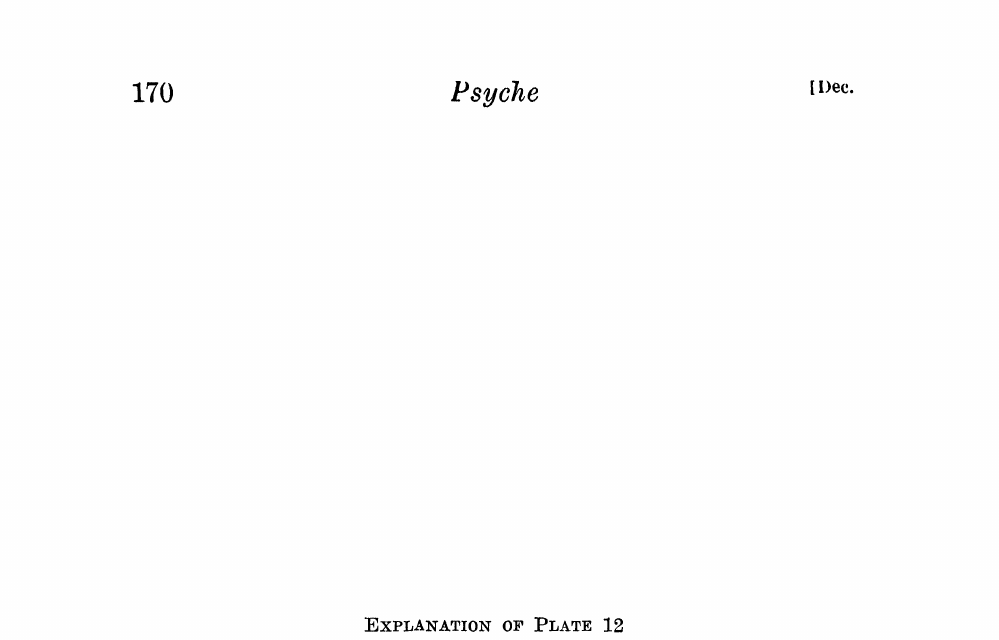
EXPLANATION OF PLATE 12 t)anorpa pusilla n. sp., fore wing of 9. (Holotype). Fig. 52. lanorpa semifasciata n. sp., fore wing of 9. (Holotype). Fig. 53. lanorpa leei n. sp., fore wing of 9. (ttolotype). Fig. 54. Neopanorpa latipennis n. sp., fore wing of 9. (tIolotype). Fig. 55. Neopanorpa varia n. sp., fore wing of 9. (Holotype). Fig. 56. lanorpa statura n. sp., fore wing of 9. Fig. 57.